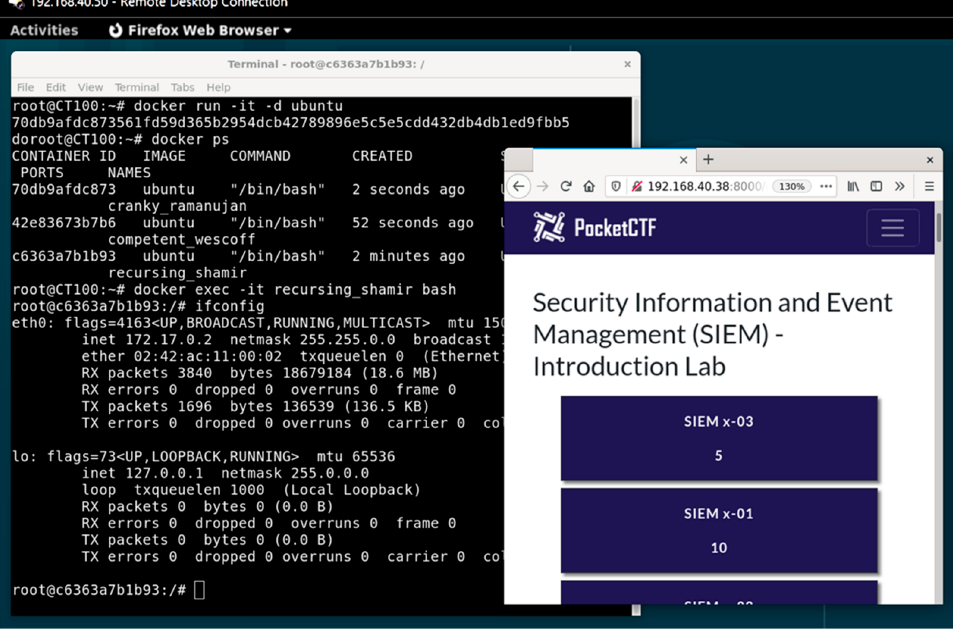
Figure 3. Accessing the LXC containers using RDP.